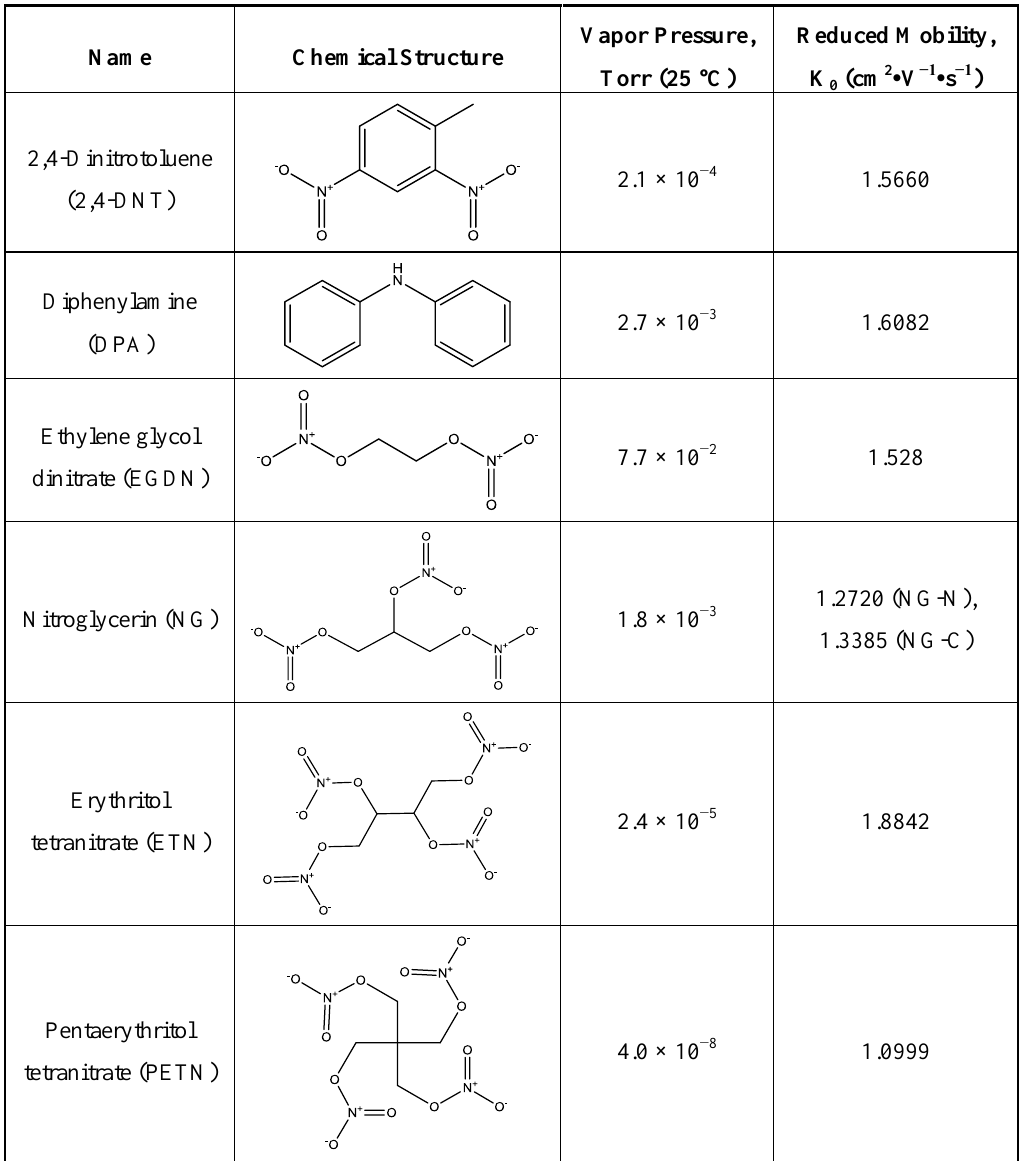
Table 1. Volatile compounds detected in smokeless powders. Vapor pressures are from references [26–30]. K values as programmed in the Smiths Detection IMS 0